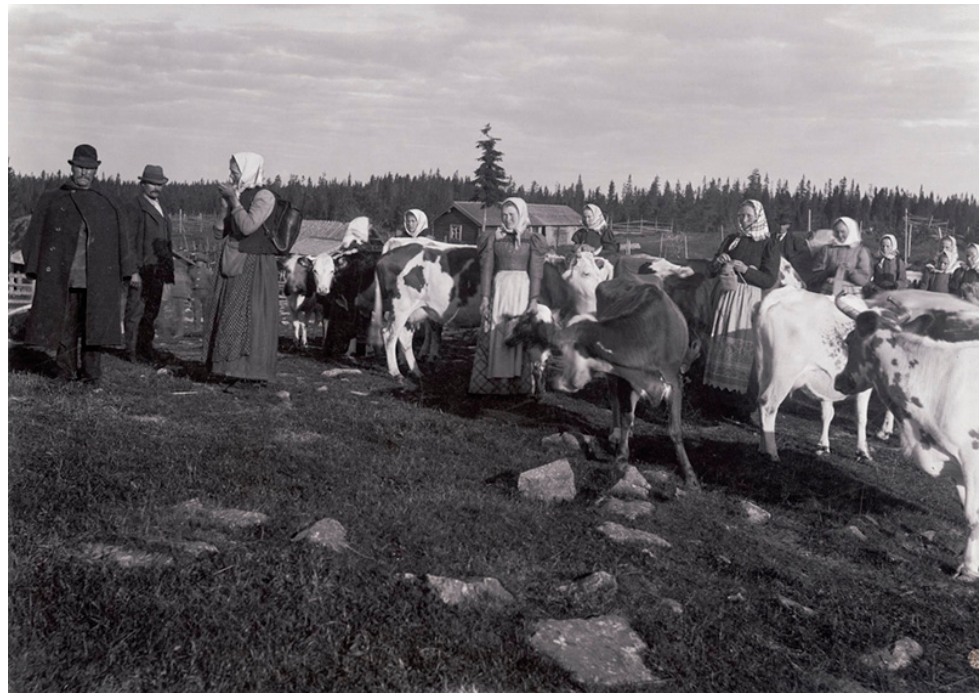
Figure 2. Nyckelberg summer farm in Malung, county of Dalarna, in the year of 1901. Note the open intensively grazed environment at the time, the female herders and visiting men. Photographer unknown. Nordiska Museet, Public Domain.